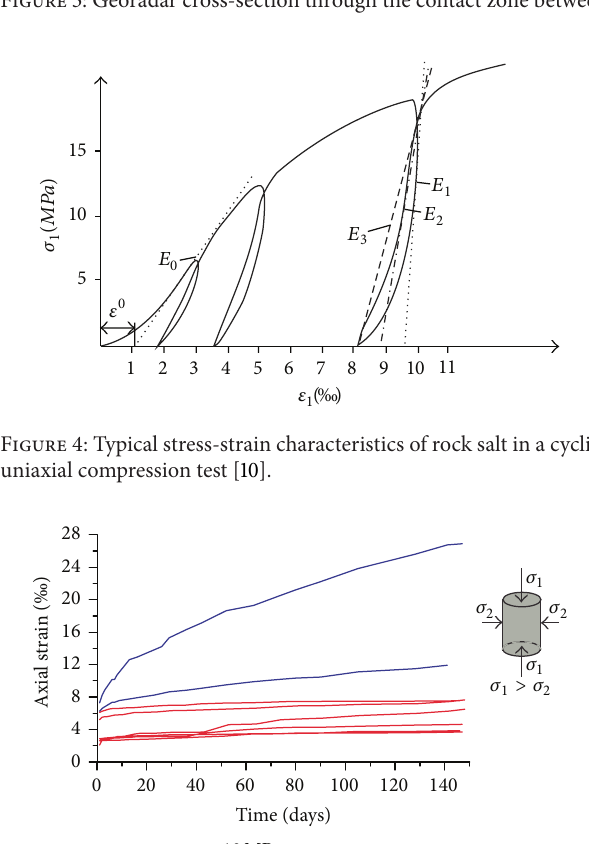
Figure 3: Georadar cross-section through the contact zone between rock salt and anhydrite layer along the side wall of the Ps-3 gallery [10].